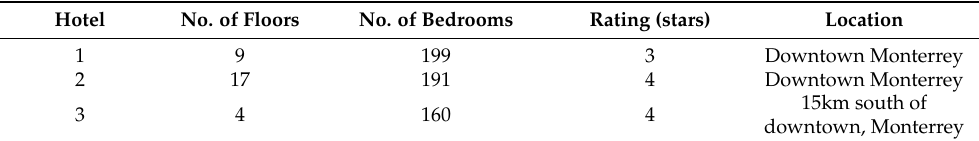
Table 1. General characteristics of hotels included in this study. Hotel No. of Floors No. of Bedrooms Rating (stars) Location 1 9 199